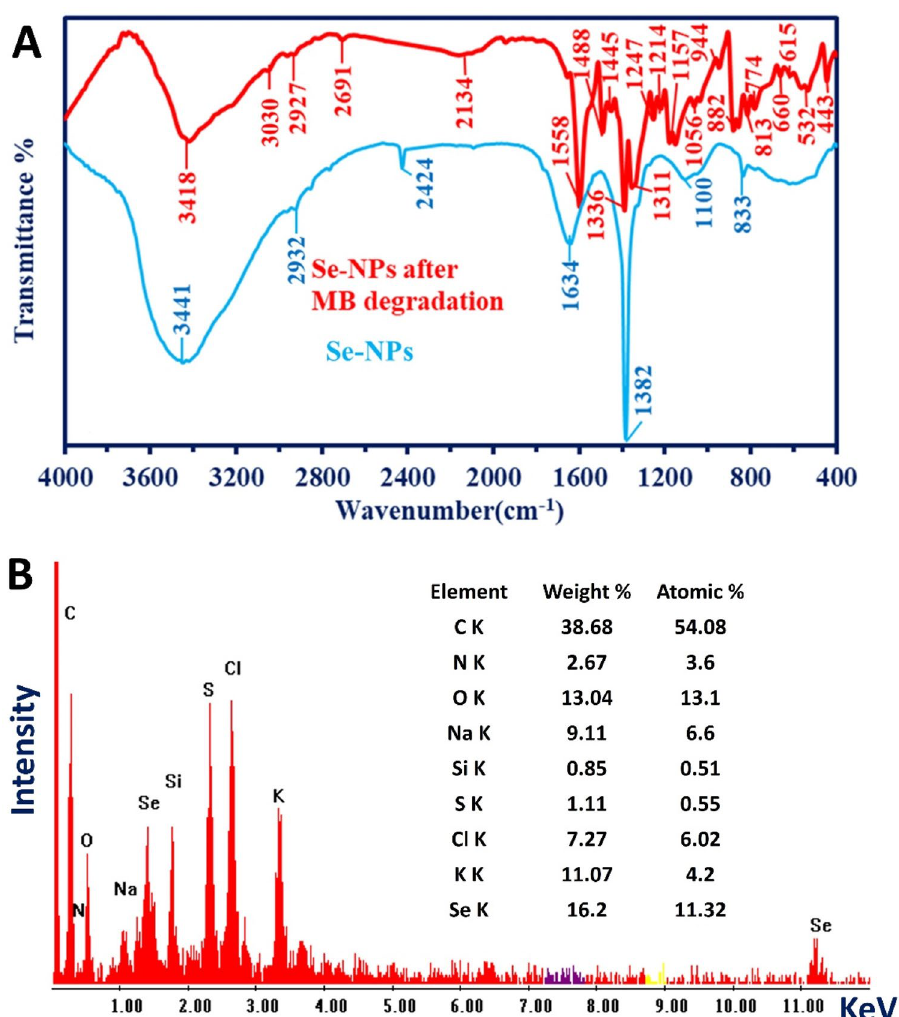
Figure 8. The FT-IR and EDX analysis of Se-NPs after adsorption with MB at optimum conditions (0.5 mg mL −1 in presence of UV-irradiation conditions after 210